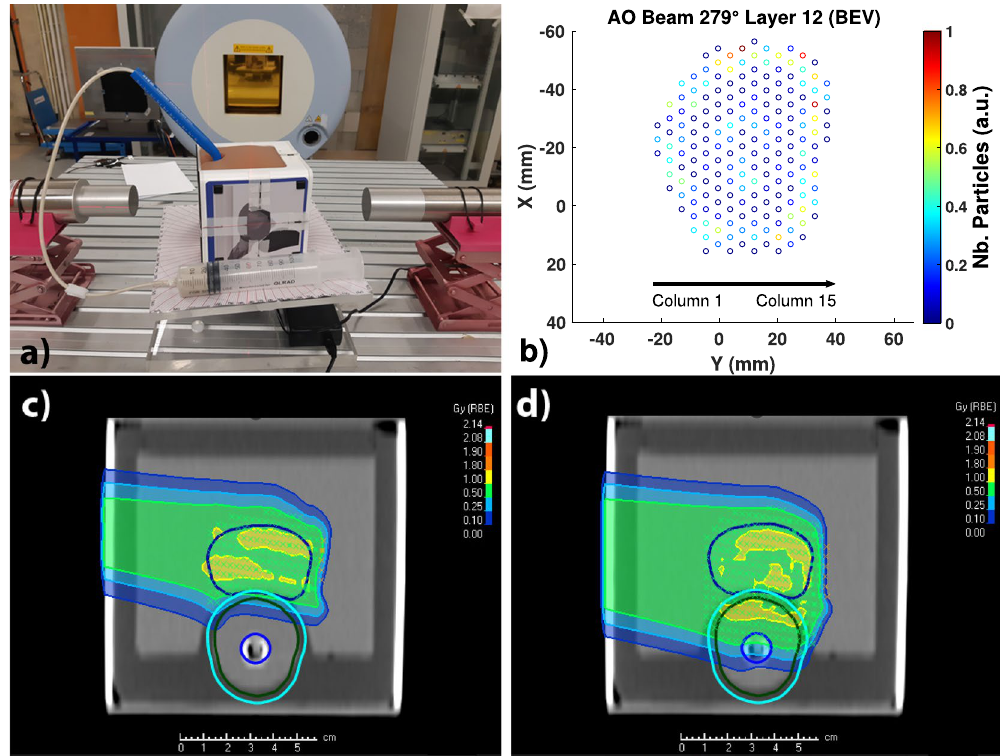
◦ Figure 6. Anterior-oblique plan for a 279 gantry angle. ( a ) Photo of the prostate phantom lying on a rotating platform commanded remotely from the control room. The ERB was closer to detector 2. ( b ) Schematics of the irradiation of each IEL in a column-wise fashion. The Y -coordinates represent the horizontal direction and increase from left to right in the BEV, and the X -coordinates represent the vertical direction and increase from top to bottom. ( c ) Plans of the AO beam conforming to the prostate ( d ), and that overlapping with the